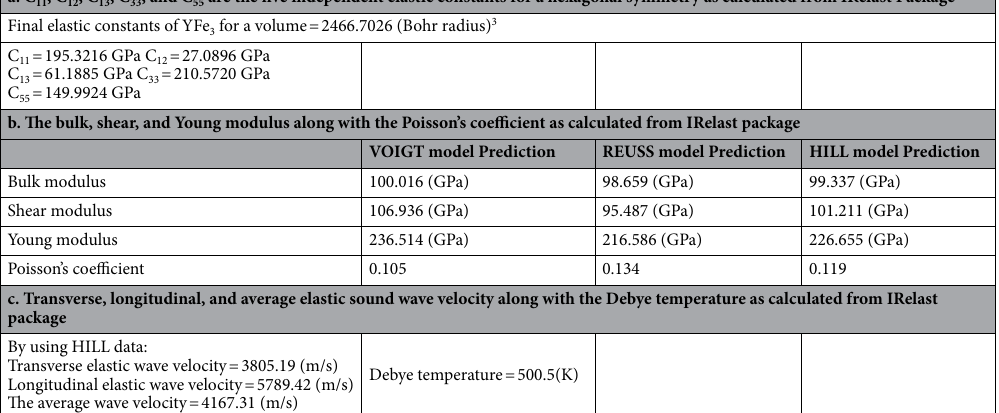
a. C 11 , C 12 , C 13 , C 33 , and C 55 are the five independent elastic constants for a hexagonal symmetry as calculated from IRelast Package Final elastic constants of YFe 3 for a volume = 2466.7026 (Bohr radius) 3